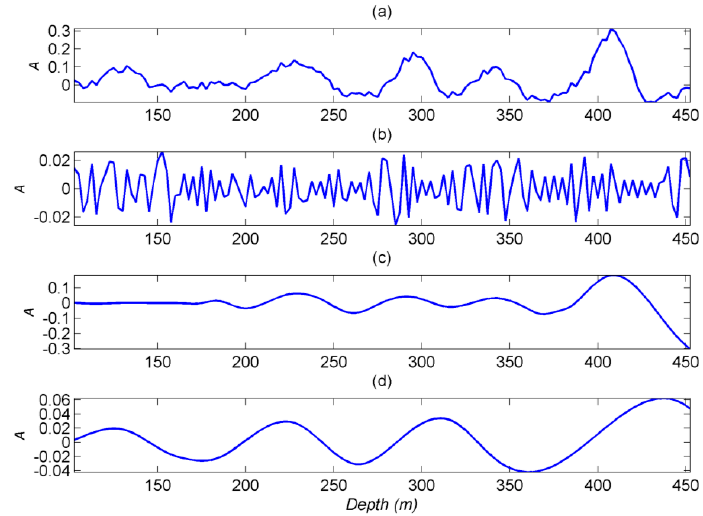
Figure 5. Analysis results of the synthetic seismic record using EMD: ( a ) the synthetic seismic record with 15% noise; ( b ) IMF1 of the record; ( c ) IMF2 of the record; and ( d ) IMF3 of the record.